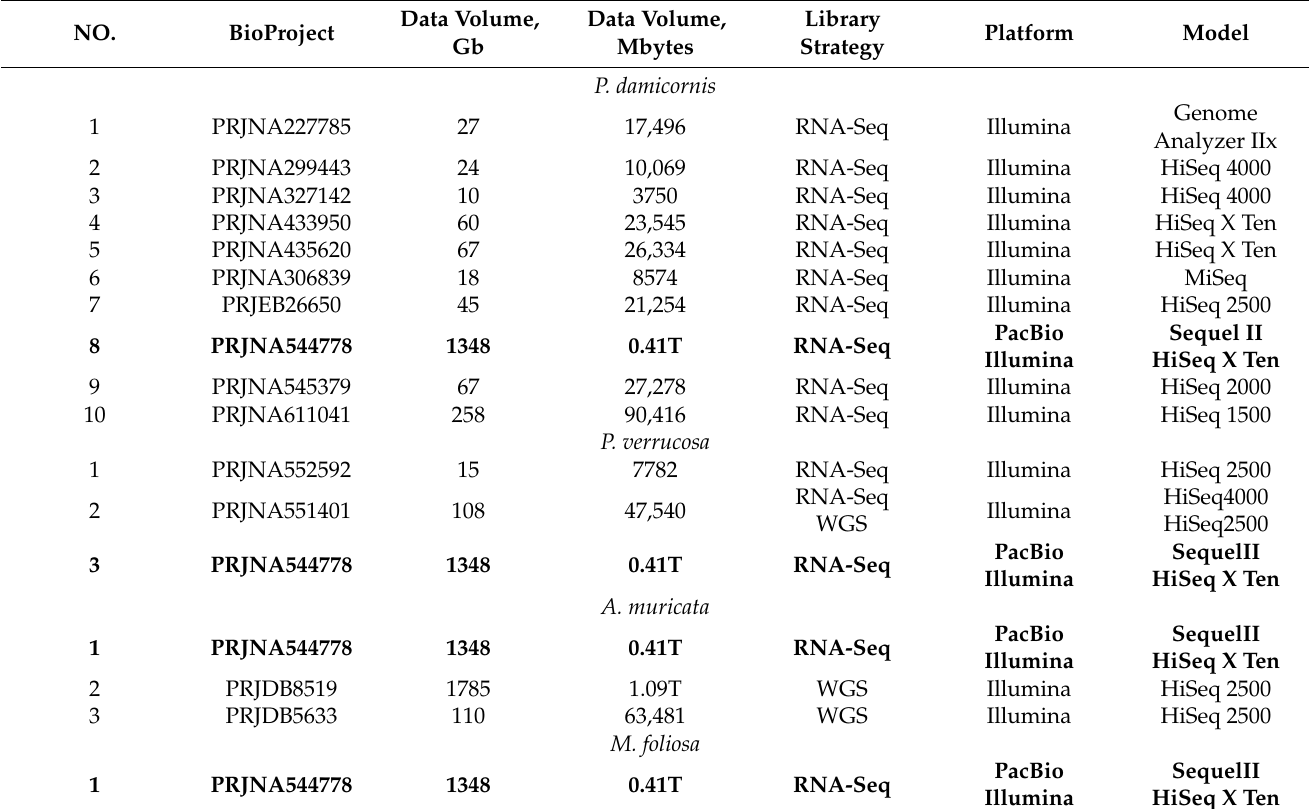
Table 1. Sequence data of four reef-building corals in the NCBI